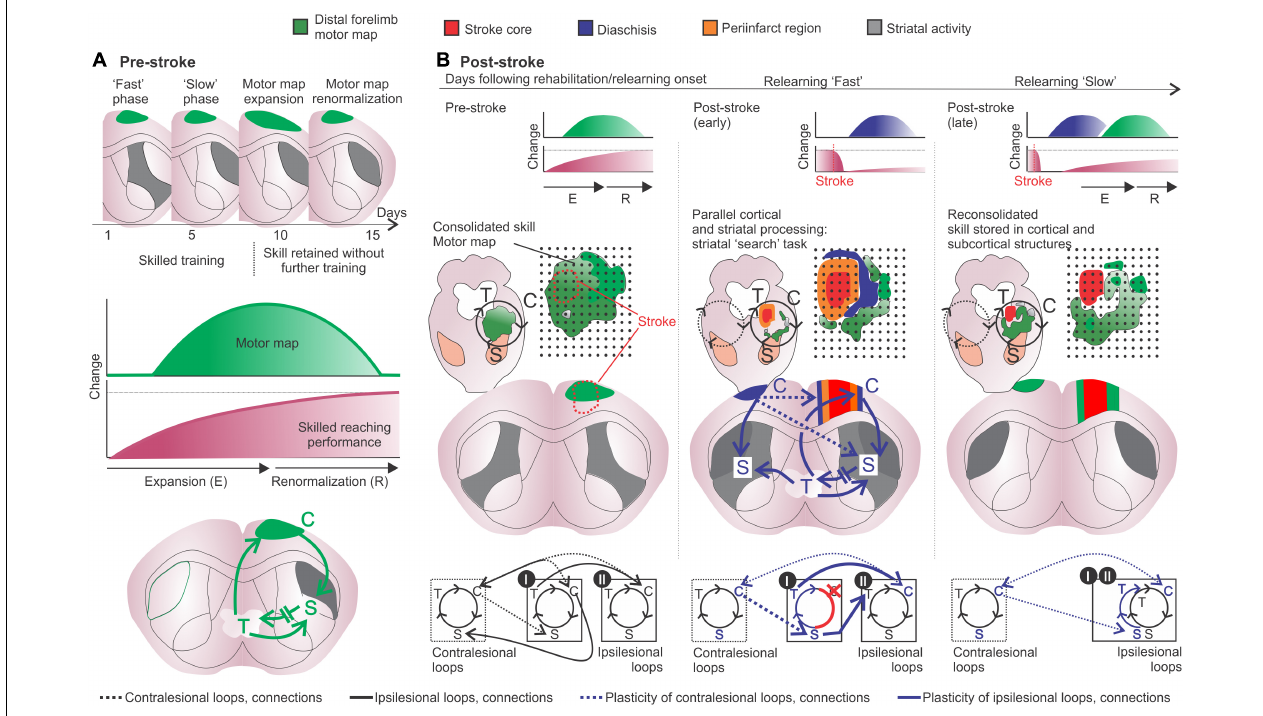
FIGURE 4 | Motor learning and post-stroke relearning. ( A , upper and middle panels) Motor learning is divided into a fast phase, with rapid improvement in performance, and a slow phase related to a “cortical learning mode” likely involved in the consolidation of motor skills. After 8–10 days of training the motor skill is acquired and transient changes imply in motor map expansion-renormalization according to the trained skill (Kleim et al., 2003; Molina-Luna et al., 2008; Wenger et al., 2017). ( A , lower panel) The motor map/engram is composed by the motor map of the acquired skill and by specific cortico-striatal-thalamo-cortical loops (green). ( B , left panels) From top to bottom, the respective motor map (green) is sustained by specific cortico-striatal-thalamo-cortical loops following motor map expansion-renormalization related to the acquired skill. The loop diagram describes the ipsilesional (black lines) and crossed (black hashed lines) connections from specific cortical, striatal and thalamic regions I and II (bottom). ( B , middle and right panels) From top to bottom, post-stroke, diaschisis may affect motor representations with, respectively, impaired skilled function. The lesion core is surrounded by dysfunctional tissue, such as periinfarct tissue (orange) and regions of focal and non-focal diaschisis (blue). Connectivity is changed and the putative participation of adjacent cortico-striatal-thalamo-cortical loops in the ipsi- and contralesional hemispheres is shown. Cortical stroke (red cross and connections) induces cellular and plastic changes (blue arrows and letters). Post-stroke cellular and plastic changes during relearning of the skilled movements may also occur in a medial to lateral fashion, similarly to motor learning and may include: increased activity in the medial portion of the ipsilesional striatum (gray); increased activity of uncrossed corticospinal fibers and of mirror-image neurons in the contralesional hemisphere (blue lines); increased activation of crossed corticostriatal fibers (blue hashed lines); short- and long-term striatal plasticity that results in increased dendritic branching and spines in the ipsi and contralesional hemispheres; the putative participation of the contralesional medial striatum during later phases of slow relearning; motor maps are reorganized and potentiated corticospinal projections to the affected muscles are available, both in the ipsi and contralesional hemispheres (i.e., crossed and uncrossed corticospinal fibers) (Pruitt et al., 2016). Connections and loops are rearranged and the newly formed motor configurations are encoded into the lateral portions of bilateral striatum. C, cortex; S, striatum; T,